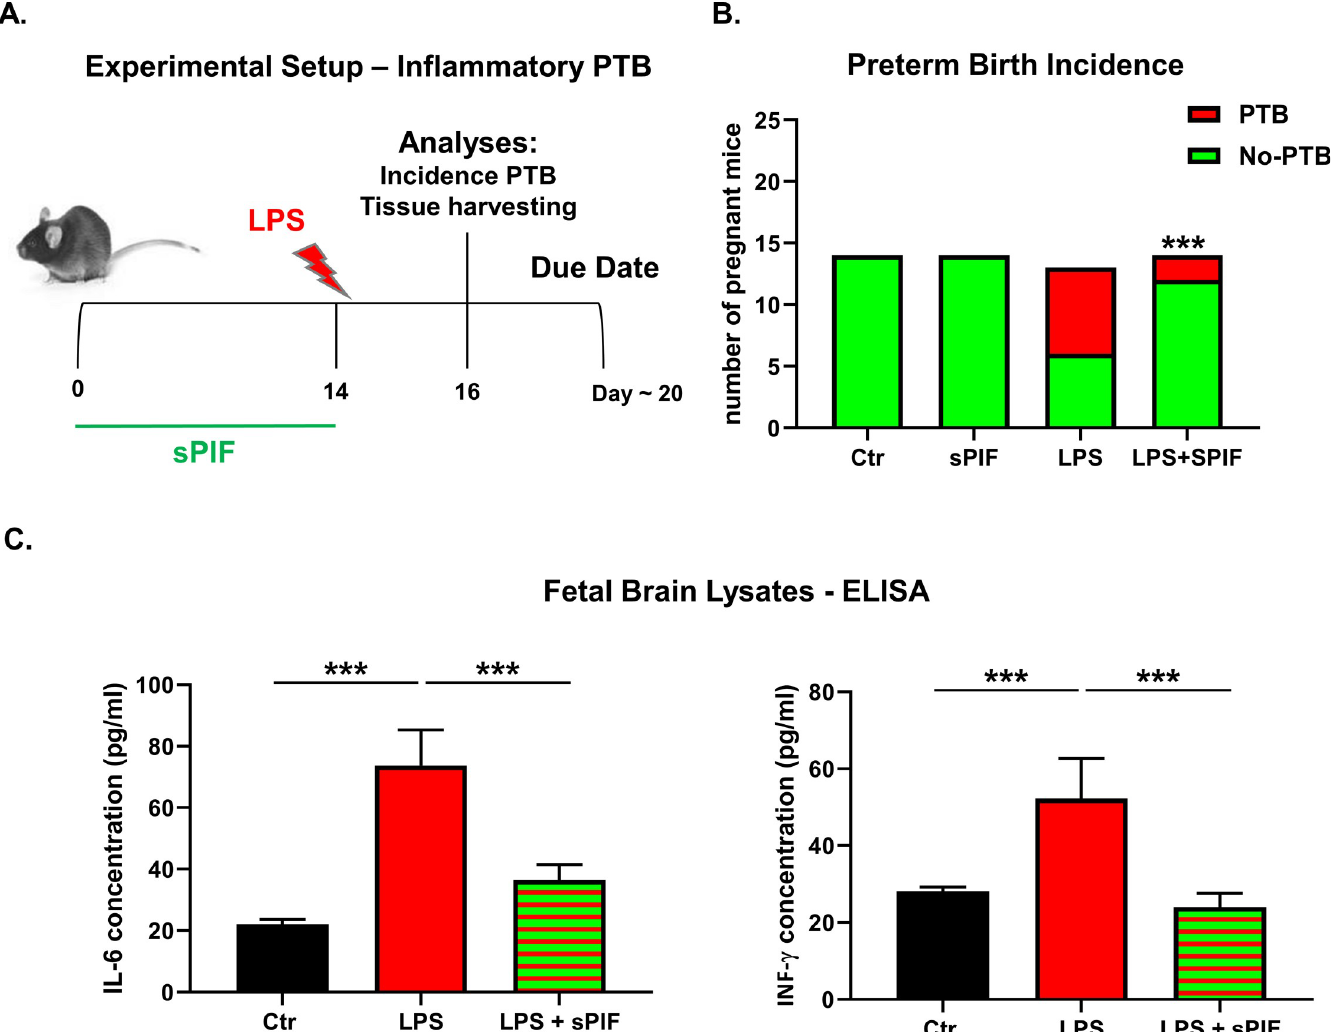
Fig 1. Experimental setup and fetal outcomes after LPS induced insult and synthetic PIF pre-treatment. A: Experimental setup: We used 4 experimental groups. Control group received PBS (200 μ l/day) on postnatal day 14 (P14) instead of LPS. Synthetic PIF group received synthetic PIF (1 μ g/g mouse/day) from P0-14 and PBS on P14 (instead of LPS). LPS group received LPS (0.1 μ g/g mouse) on P14 and LPS/sPIF group received both LPS and synthetic PIF (same as above). B: The incidence of PTB. C: In fetal brain lysates maternal sPIF pre-treatment reduces pro-inflammatory cytokines IL-6 and INF γ . ��� p < 0.001. sPIF: synthetic PreImplantation Factor; LPS: Lipopolysaccharides. PTB: Preterm Birth. Data are mean ± SD.